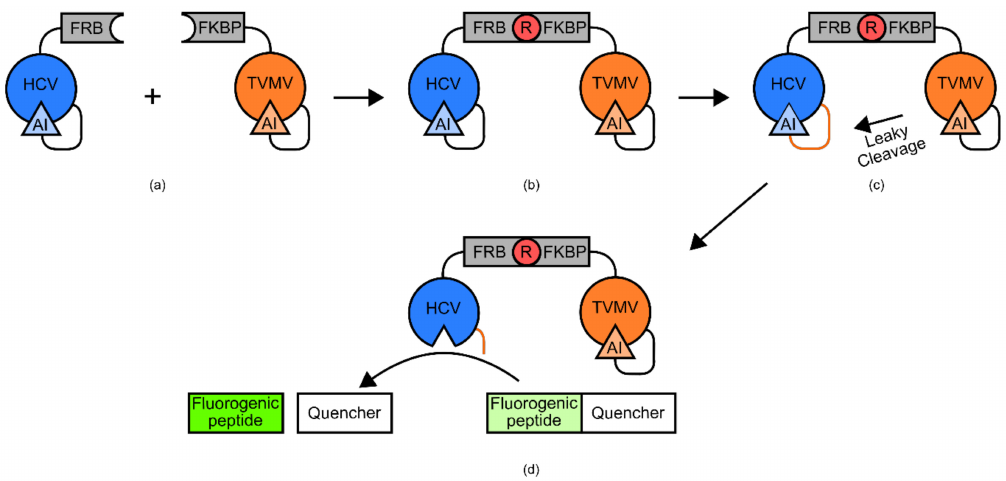
Figure 15. Rapamycin biosensor built using two separate fusion proteins. The first fusion protein is a rapamycin-binding FRB domain attached via a tether to a hepatitis C virus NS3 serine